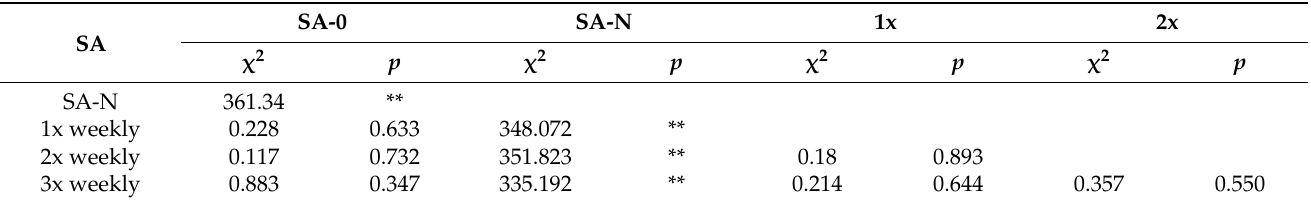
Table 4. Chi-squared test correlation between groups of SA